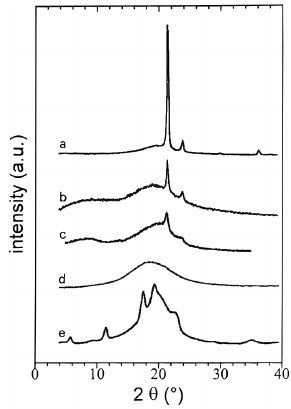
Figure 3. Wide-angle X-ray diffraction spectra of: high-density polyethylene (HDPE) sample ( a ) and ethylene–styrene (ES) copolymers at increasing styrene content ( b – e ). Reproduced from [24] with authorization of American Chemical Society.